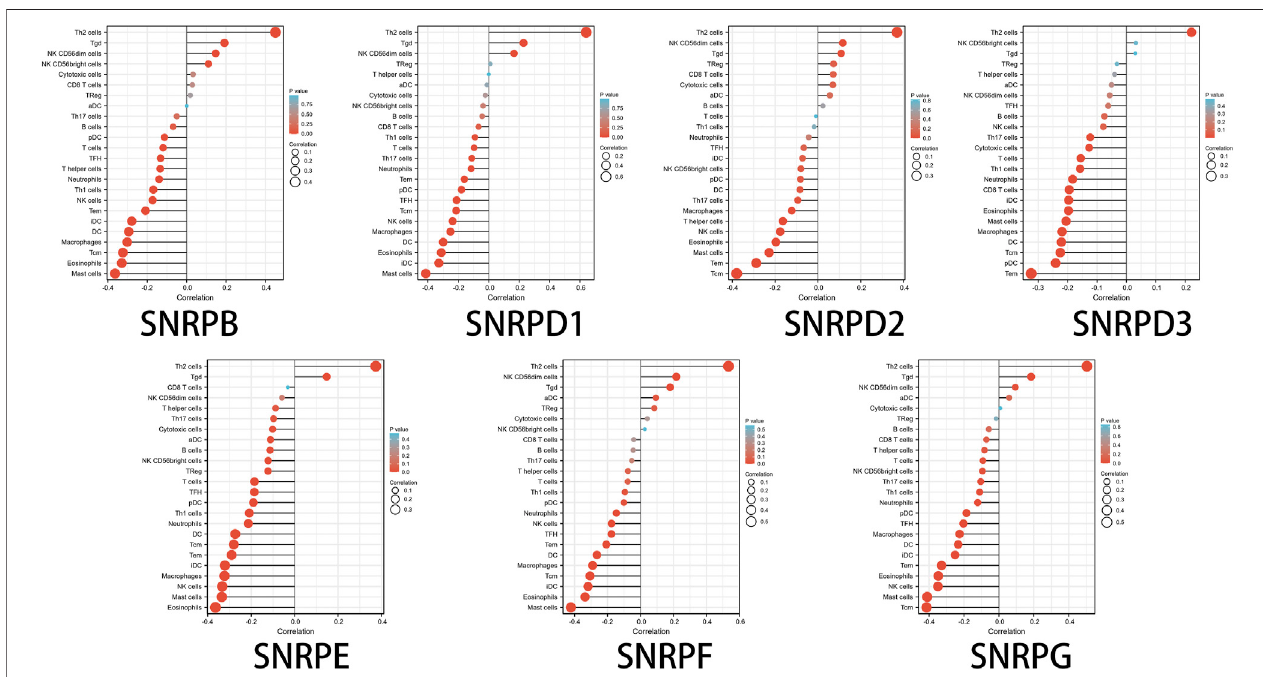
FIGURE 8 | The lollipop charts of the associations between 24 immune cell types and Sm